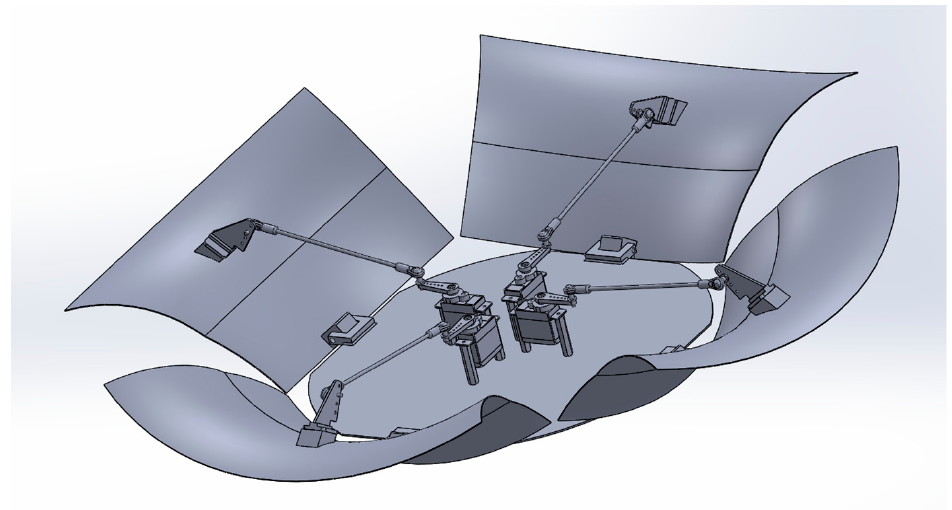
Figure 11. The implementation of reflector movement using motorized arms.